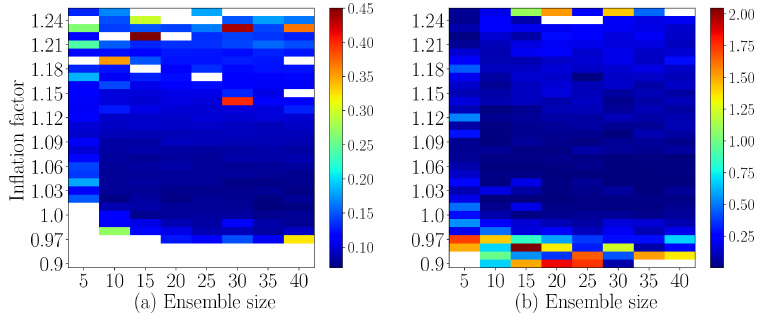
Figure 15. Data assimilation results with DEnKF applied to Lorenz-96 system. RMSE results on a log scale are shown in panel (a) . The KL distances between the analysis rank histogram and a uniform rank histogram are shown in panel (b) . The localization radius is fixed to 4.